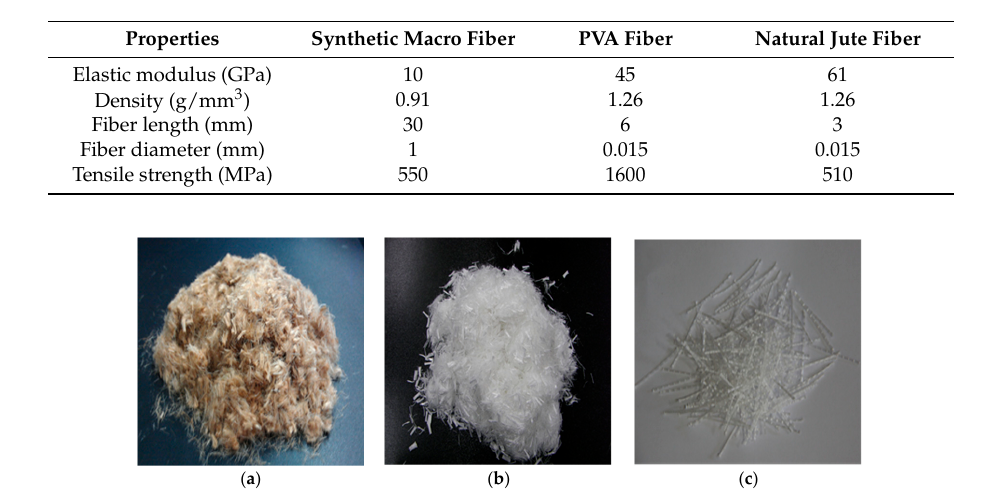
Figure 1. Geometry of fibers. ( a ) Jute fiber; ( b ) PVA fiber; ( c ) Macro synthetic fiber.